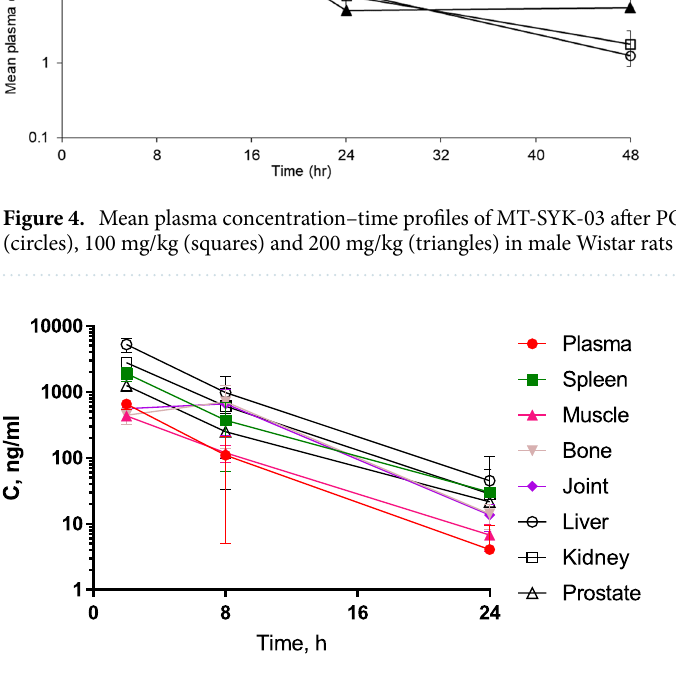
Figure 5. The dynamics of MT-SYK-03 concentration in various tissues after a single oral administration in